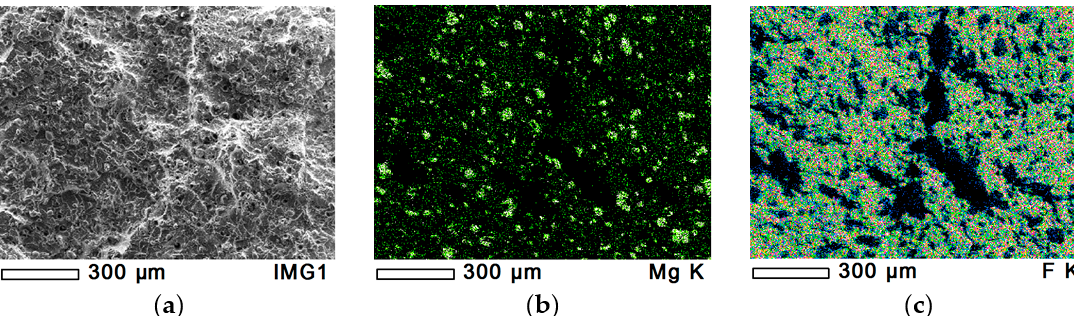
Figure 5. EDS analysis of PTFE / MG70-4 sample with 100 × magnification. ( a ): original cryo-fractured surface, ( b ): magnesium content and ( c ): fluorine content.